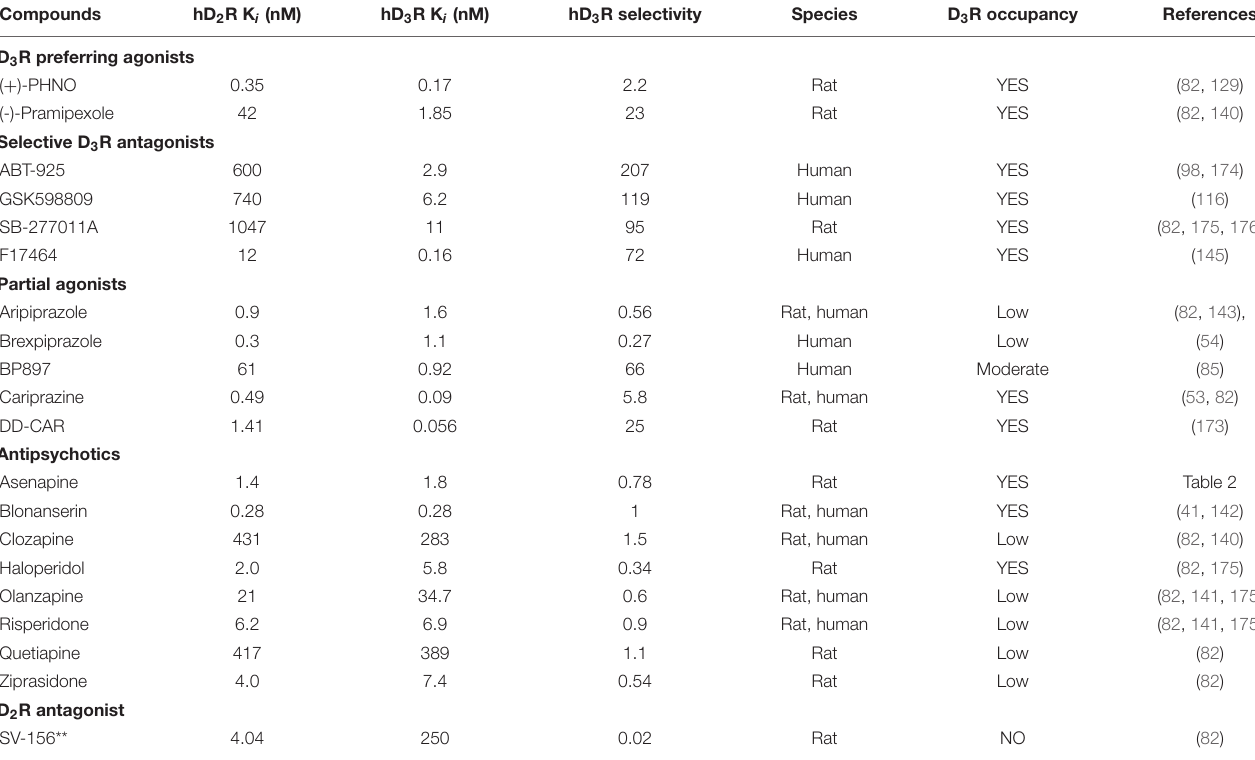
TABLE 3 | Summary of in vitro human D 3 R affinity, D 3 R selectivity and occupancy* of some antipsychotics, partial agonists, highly preferring/selective D 3 R agonists, antagonists.